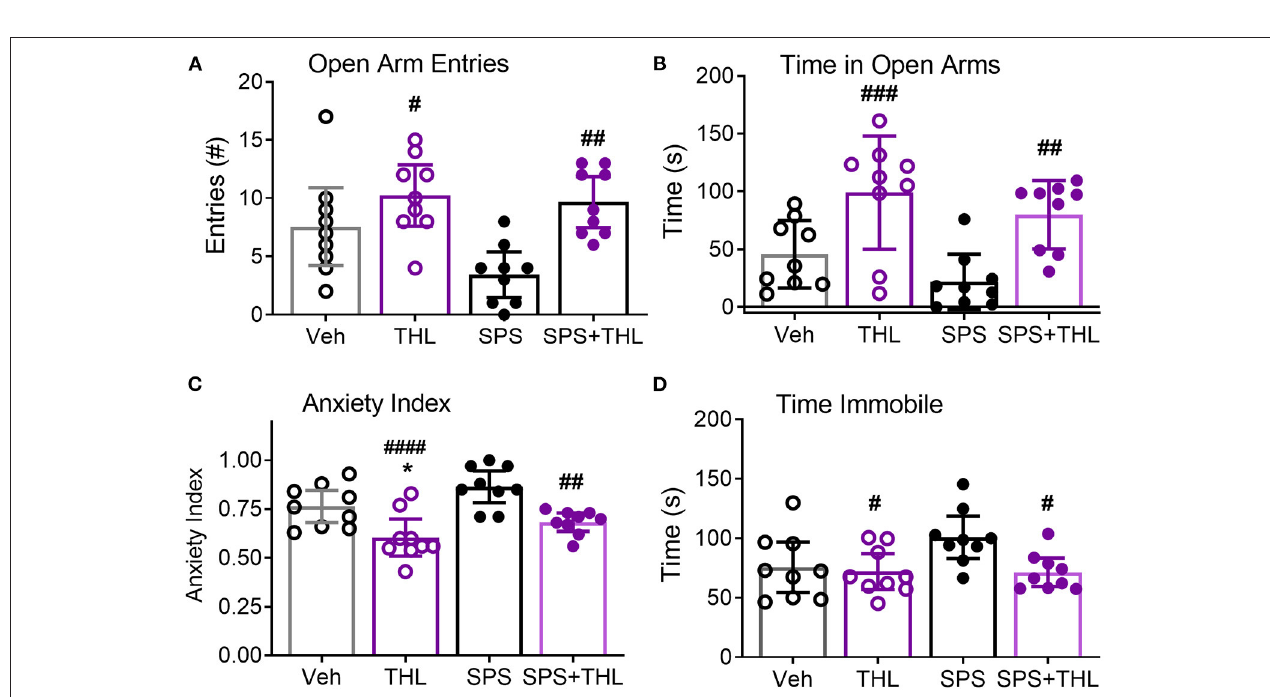
FIGURE 5 | THL modulates anxiety-like behaviors in vehicle-treated control and SPS rats. Results of four different parameters are shown: Open arm entries (A) , Time in open arms (B) , Anxiety index (C) , and Time immobile (D) . Data are represented as scatter plots of N = 9/group, with 95% CI. Post-hoc analysis indicates significant effects of THL treatment alone: differs from Veh-treated (* p < 0.05) and SPS ( # p < 0.05, ## p < 0.01, ### p < 0.001, and #### p < 0.0001.).